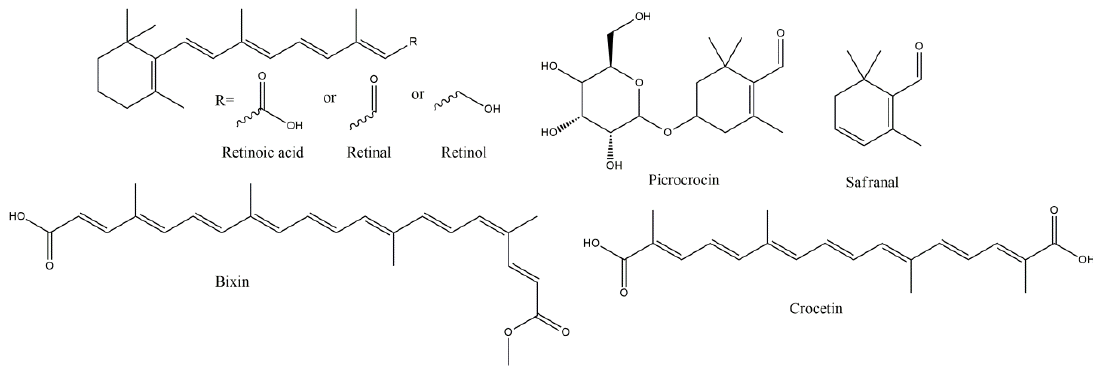
Figure 6. Vitamin A and Carotenoids with anti-MS